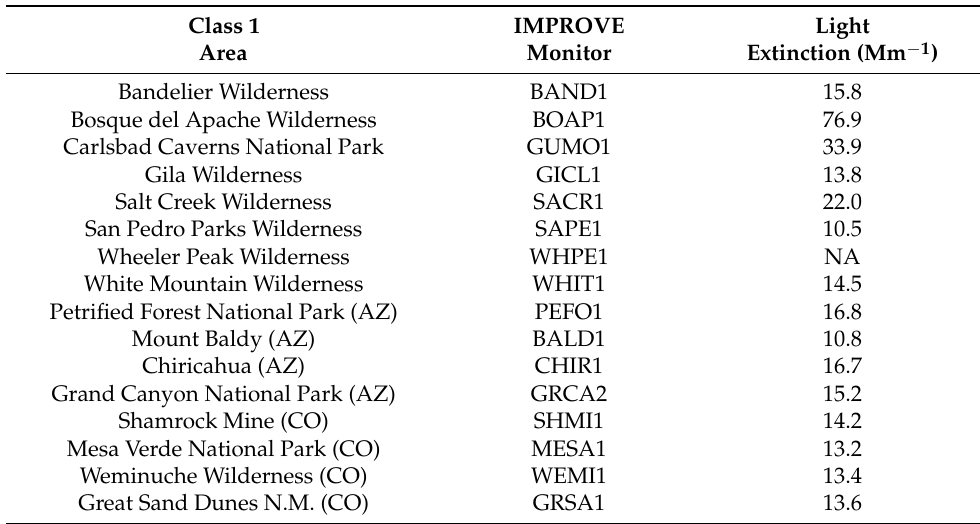
Table 2. IMPROVE monitoring site reconstructed 24 h average light extinction coefficient (Mm − 1 ) data for 28 November 2018. NA = Data Not Available.